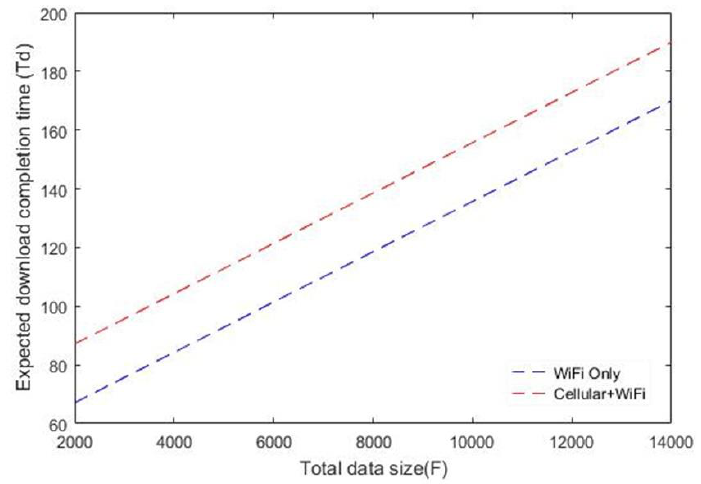
Figure 6. Data size vs. download time